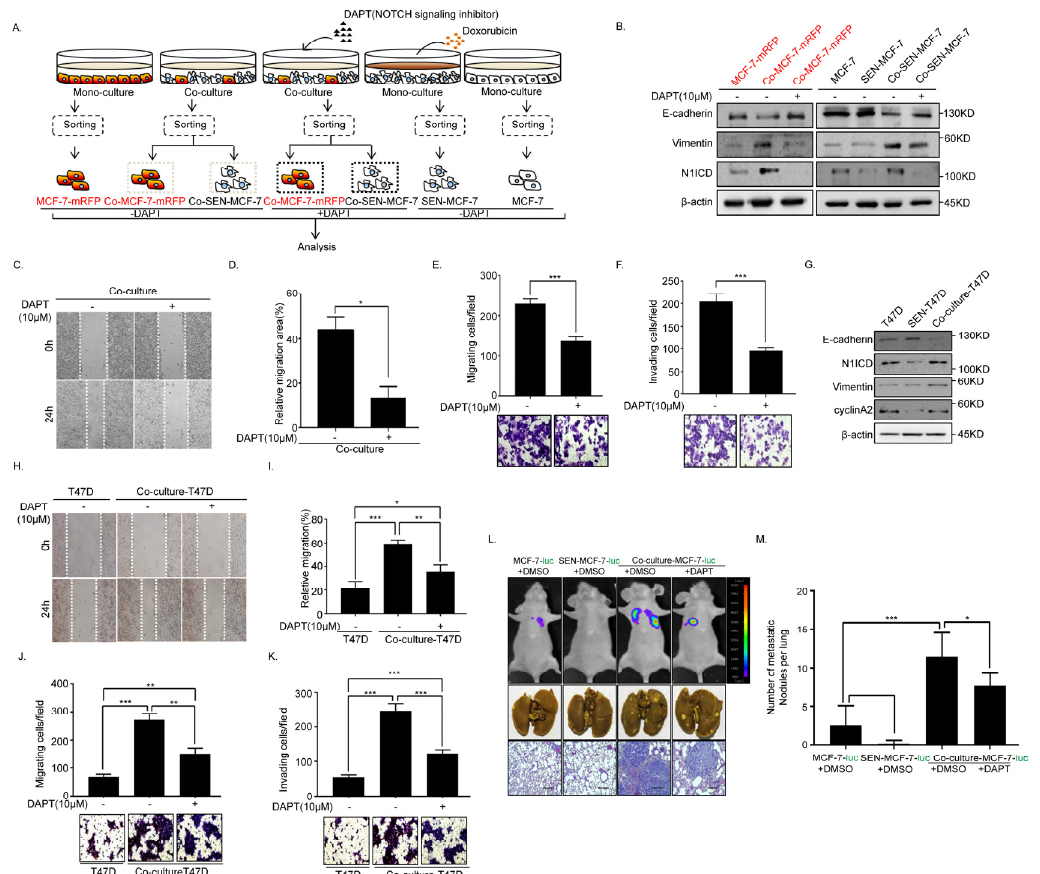
Figure 4. N -[(3,5-Difluorophenyl)acetyl]-l-alanyl-2-phenyl]glycine-1,1-dimethylethyl ester (DAPT) inhibits EMT and metastasis of the senescent and adjacent non-senescent breast cancer cells. ( A ) Scheme showing the experimental setup. Flow cytometry analysis of collected breast cancer cells in co-cultures or monocultures treated with or without DAPT (10 µ M). ( B ) Immunoblot analysis of protein expression of active Notch1 intracellular domain (N1ICD), E-cadherin, and Vimentin in MCF-7-mRFP and MCF-7 cells treated with or without DAPT. ( C , D ) Wound-healing assay of MCF-7 cells (MCF-7-mRFP and SEN-MCF-7) treated with or without DAPT. ( C ) Representative micrographs of the wound-healing assay are shown. ( D ) Data represent the relative migration ratio of cells per field (error bars indicate mean SD, n = 3 experimental replicates, * p < 0.05). ( E ) Migration assay of MCF-7 cells (MCF-7-mRFP and SEN-MCF-7) treated with or without DAPT. Representative micrographs of migrated cells are shown. Data represent the number of cells derived from mean cell counts of five fields (error bars indicate mean SD, n = 3 experimental replicates, *** p < 0.001). ( F ) Invasion assay of MCF-7 cells (MCF-7-mRFP and SEN-MCF-7) with indicated treatments. Representative micrographs of the migrated cells are shown. Data represent the number of cells derived from mean cell counts of five fields (error bars indicate mean SD, n = 3 experimental replicates, * p < 0.05, ** p < 0.01, *** p < 0.001). ( G ) Immunoblot analysis of protein expression of E-cadherin, Vimentin, N1ICD, and cyclinA2 in T47D, SEN-T47D and Co-culture-T47D (which contains T47D and SEN-T47D). ( H , I ) Wound-healing assay of T47D subjected to the indicated treatments. ( H ) Representative micrographs of the wound-healing assay are shown. ( I ) Data represent the relative migration ratio of cells per field (error bars indicate mean SD, n = 3 experimental replicates, * p < 0.05, ** p < 0.01, *** p < 0.001). ( J ) Migration assays of T47D cells with the indicated treatments. Representative micrographs of migrated cells are shown. Data represent the number of cells derived from mean cell counts of five fields (Error bars indicate mean SD, n = 3 experimental replicates, ** p < 0.01, *** p < 0.001). ( K ) Invasion assay of T47D cells with the indicated treatments. Representative micrographs of migrated cells are shown. Data represent the number of cells derived from mean cell counts of five fields (error bars indicate mean SD, n = 3 experimental replicates, *** p < 0.001). ( L ) Lung metastatic nodules were confirmed by hematoxylin and eosin staining. Scale bars, 250 µ m. ( M ) The number of visible surface metastatic lesions in lungs was counted (error bars indicate mean SD, n = 6 mice for each group, * p < 0.05, *** p <